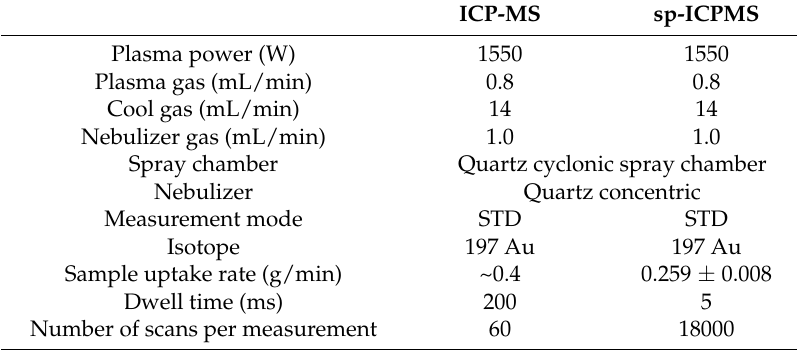
Table 1. Operating parameters of Thermo iCAPQ in ICPMS and single particle (sp)-ICPMS